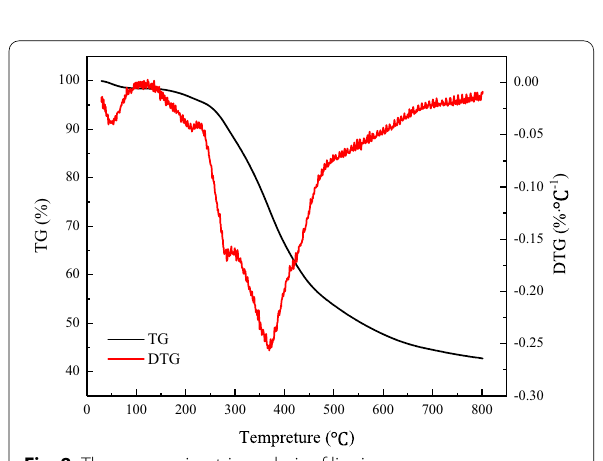
Fig. 8 Thermo-gravimetric analysis of lignin